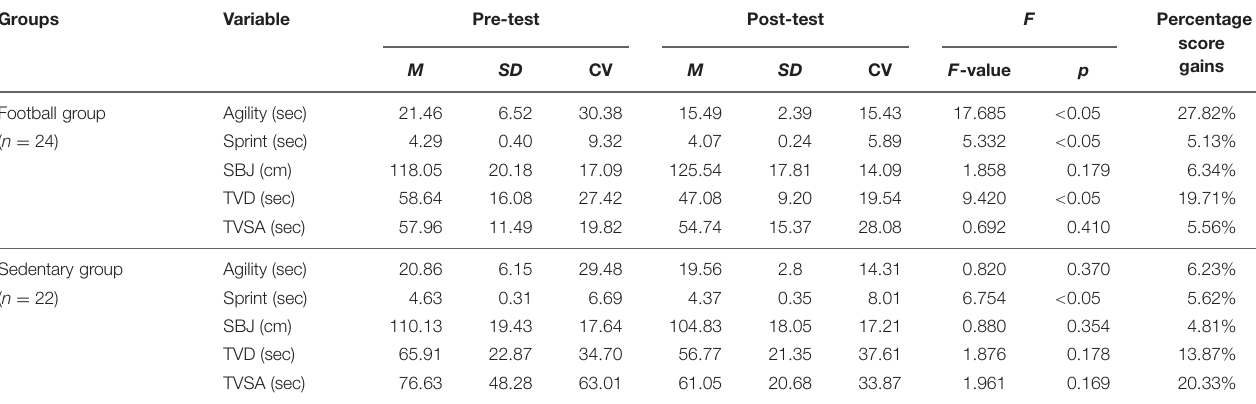
TABLE 3 | Performance variables studied in both groups.